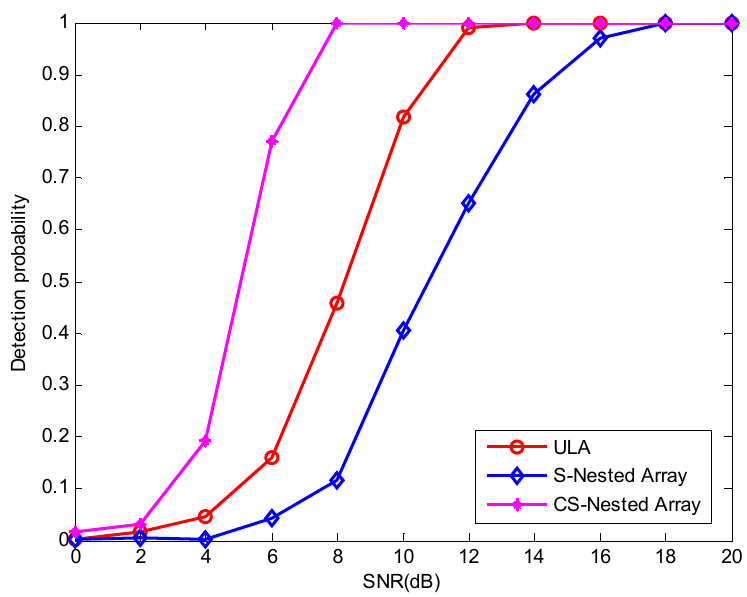
Figure 5. Comparison of resolution ability among the three methods.